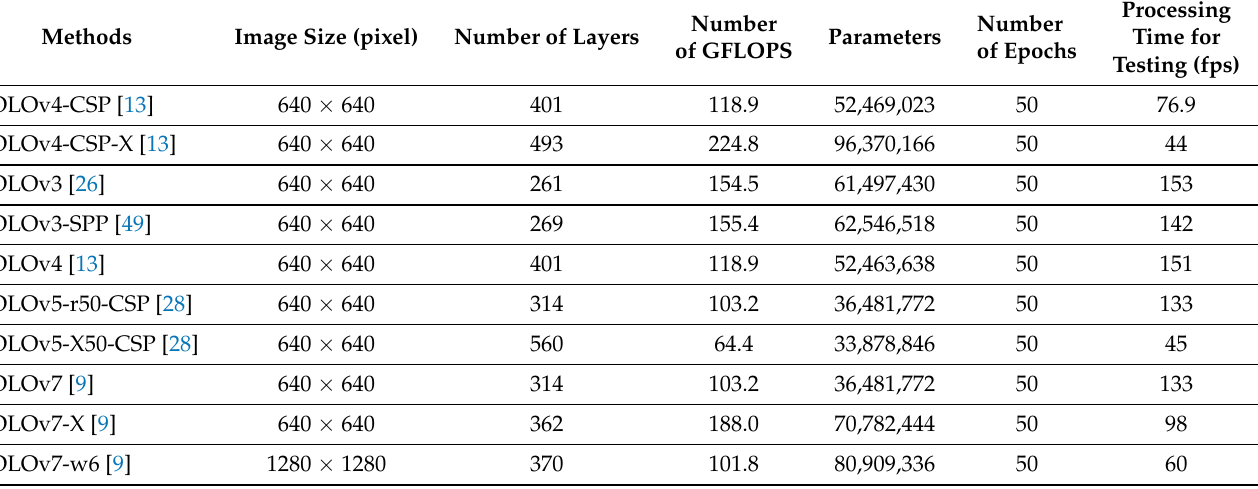
Table 1. The list of parameters of YOLOv7 and its variants [9], resulting in the processing time of the networks when evaluated on the testing set of the FPHAB dataset.